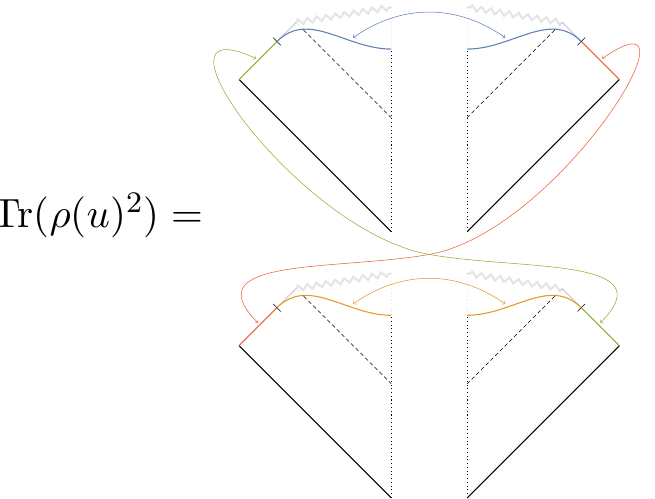
Figure 7. To compute Tr( ρ ( u ) 2 ) , we perform the path integral on the geometry built from two replicas of figure 6, identified as